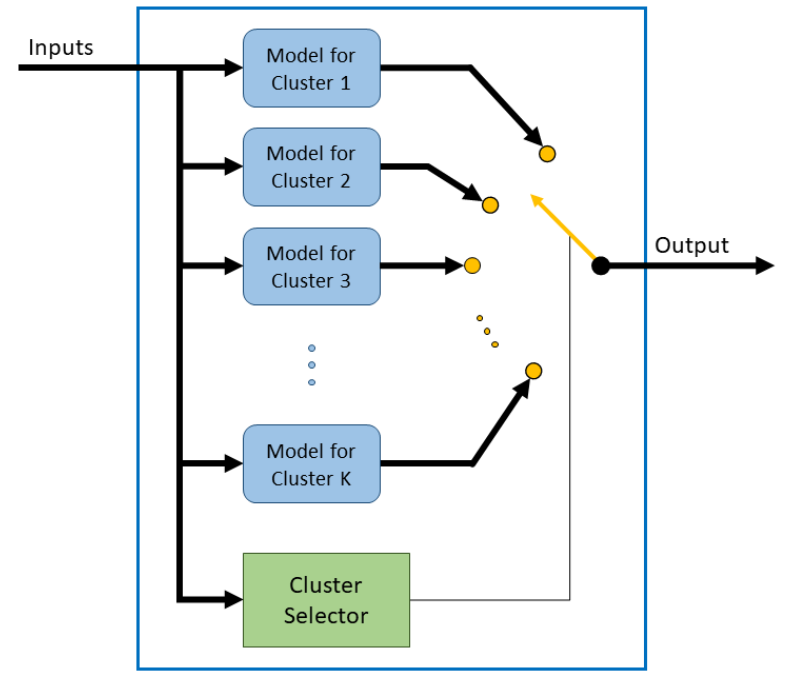
Figure 5. Internal schematic to achieve the hybrid